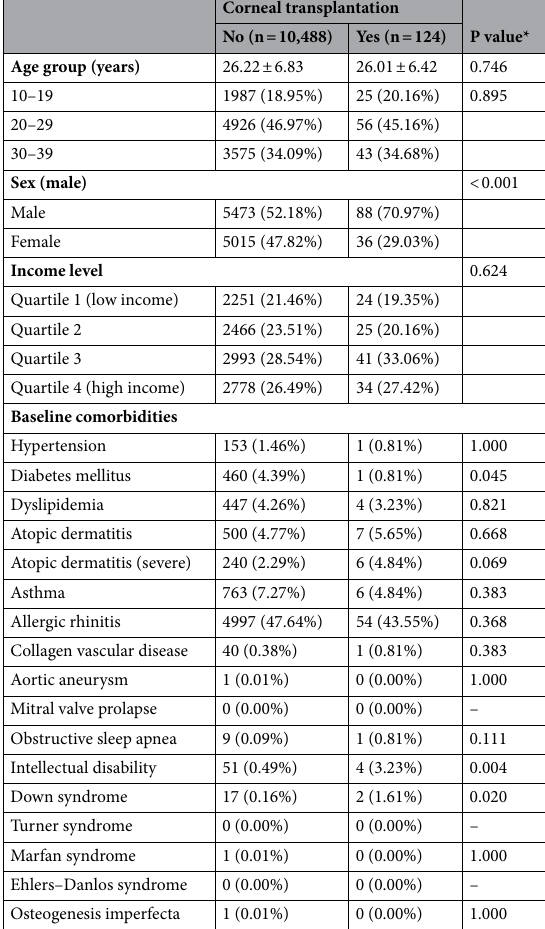
Table 1. Descriptive characteristics of patients with keratoconus who did and did not undergo corneal transplantation. *P values were determined using the independent t test for continuous variables and Fisher’s exact test for categorical